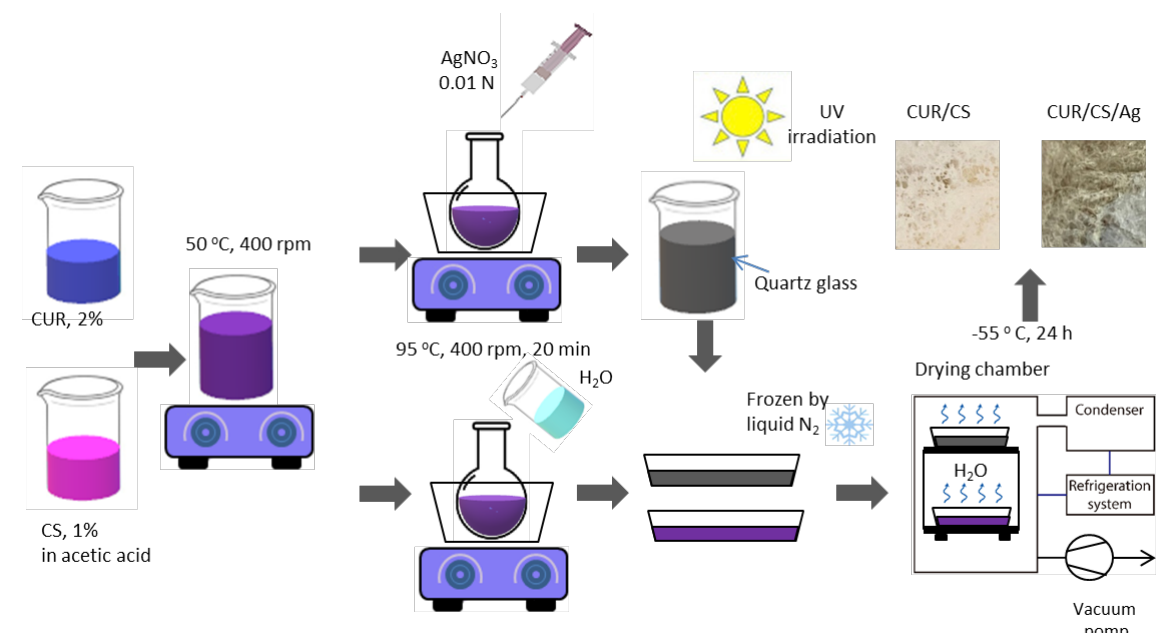
Figure 1. Schematic of curdlan/chitosan and curdlan/chitosan/Ag foam synthesis.